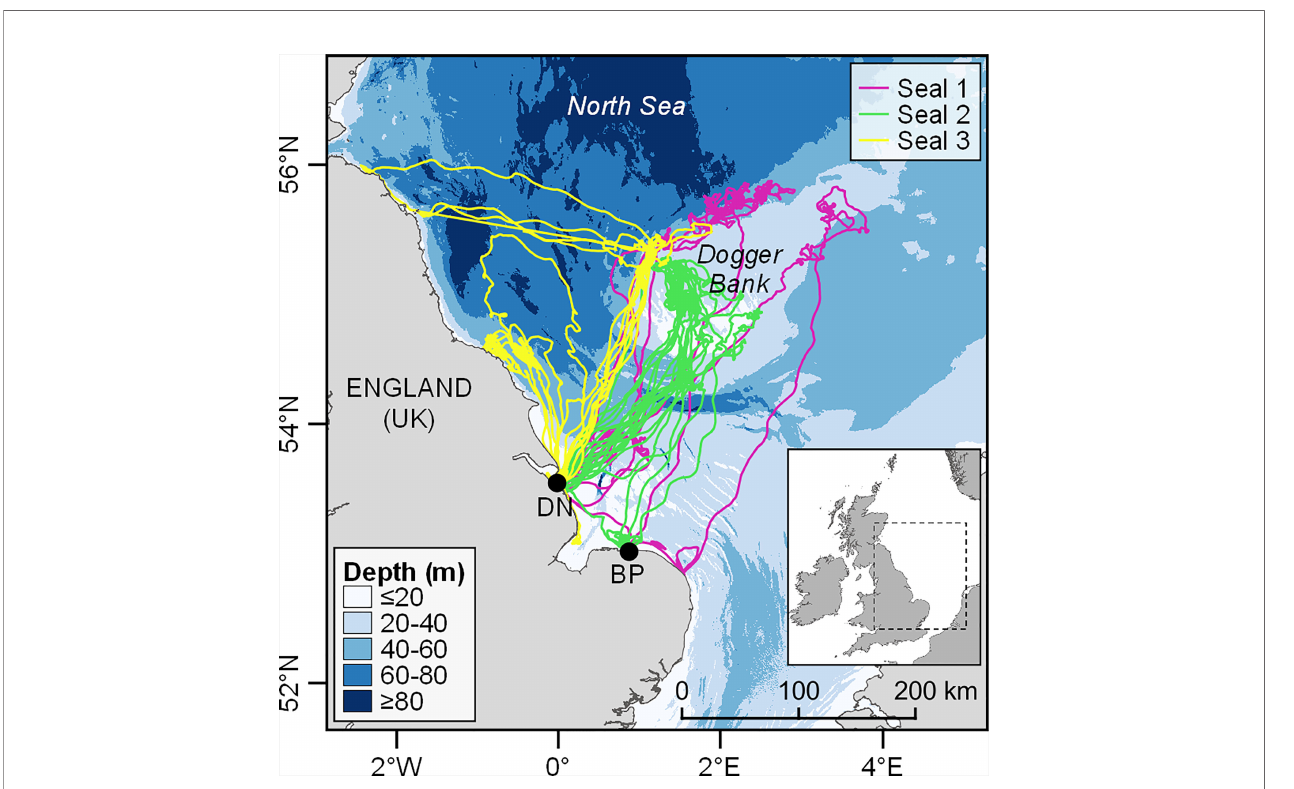
FIGURE 1 | At-sea movements of the three tagged grey seals. Black dots indicate the tagging sites (DN = Donna Nook, BP = Blakeney Point). Bathymetry data: EMODnet Digital Bathymetry (DTM)